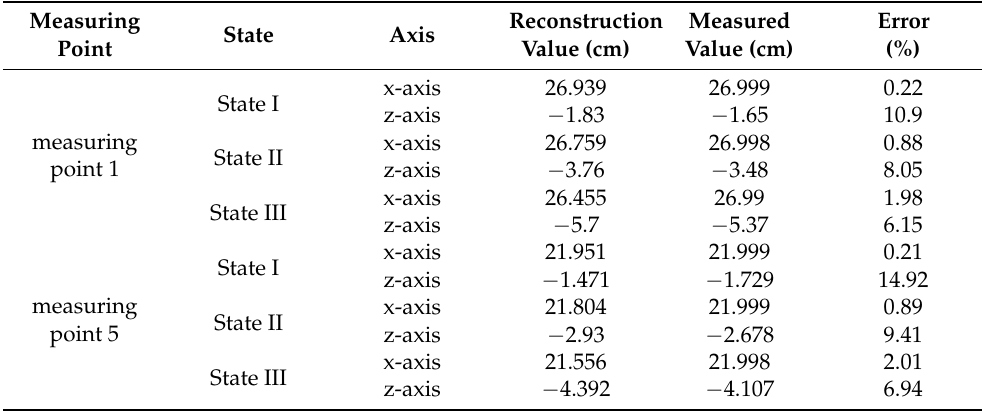
Table 5. Figure 14a comparison table of coordinate values of measuring points.